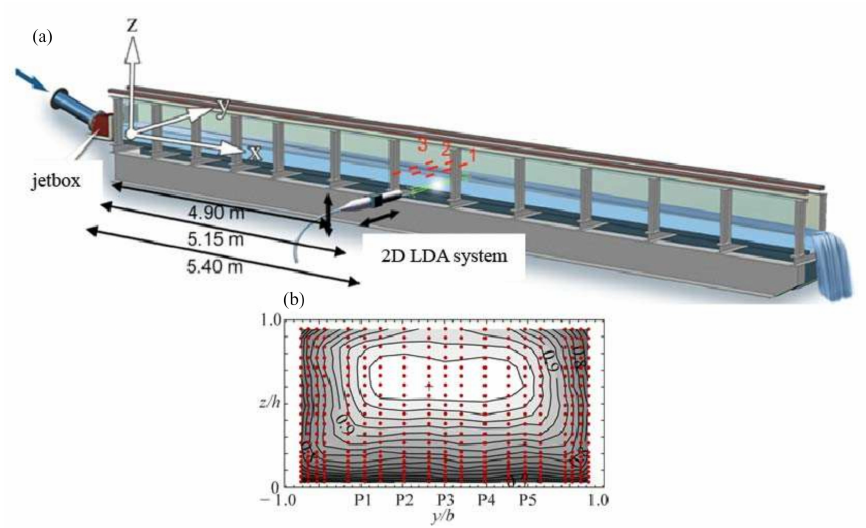
Figure 1. ( a ) Laboratory model flume and measurement cross-sections at x = 4.90, 5.15, and 5.40 m, and ( b ) detailed velocity measurement points (19 profiles at cross-section x = 4.90 m, 5 profiles P1–P5 at cross sections x = 5.15 and 5.40